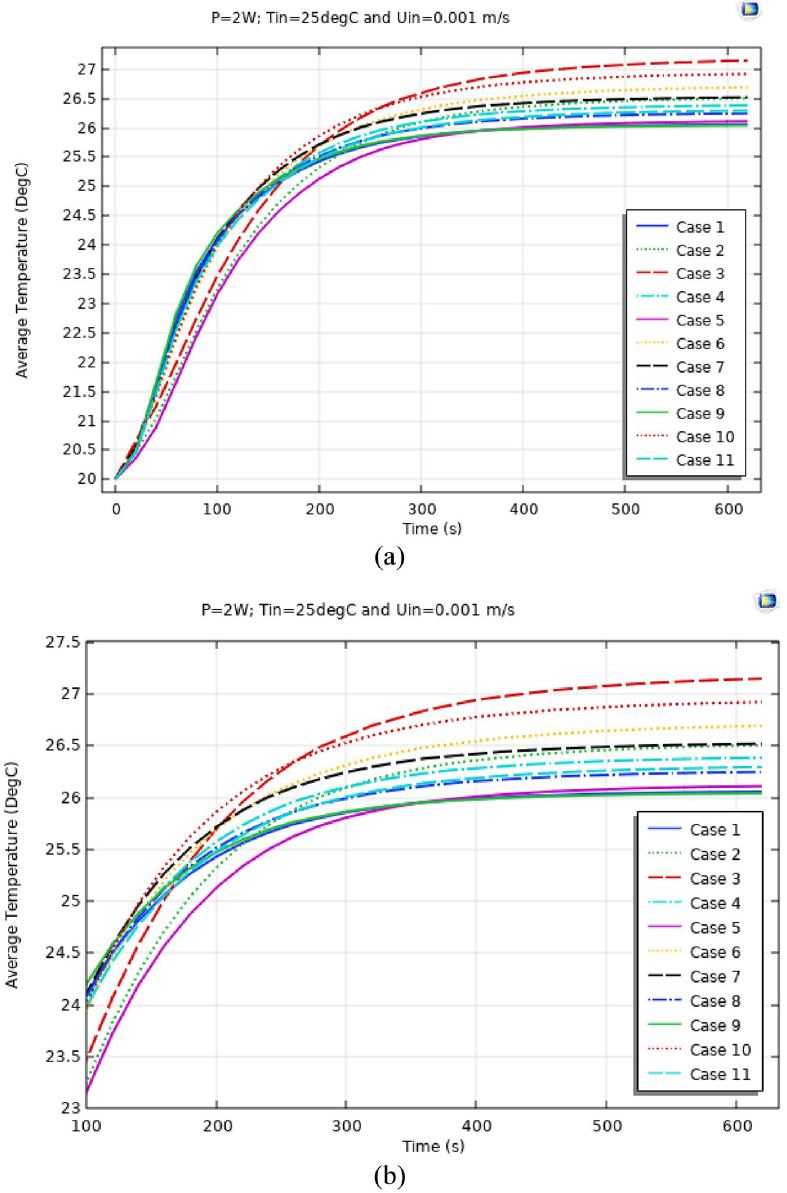
Figure 10. Average Temp. when P = 2 W for different 11 cases ( a ) complete view, ( b ) zoomed